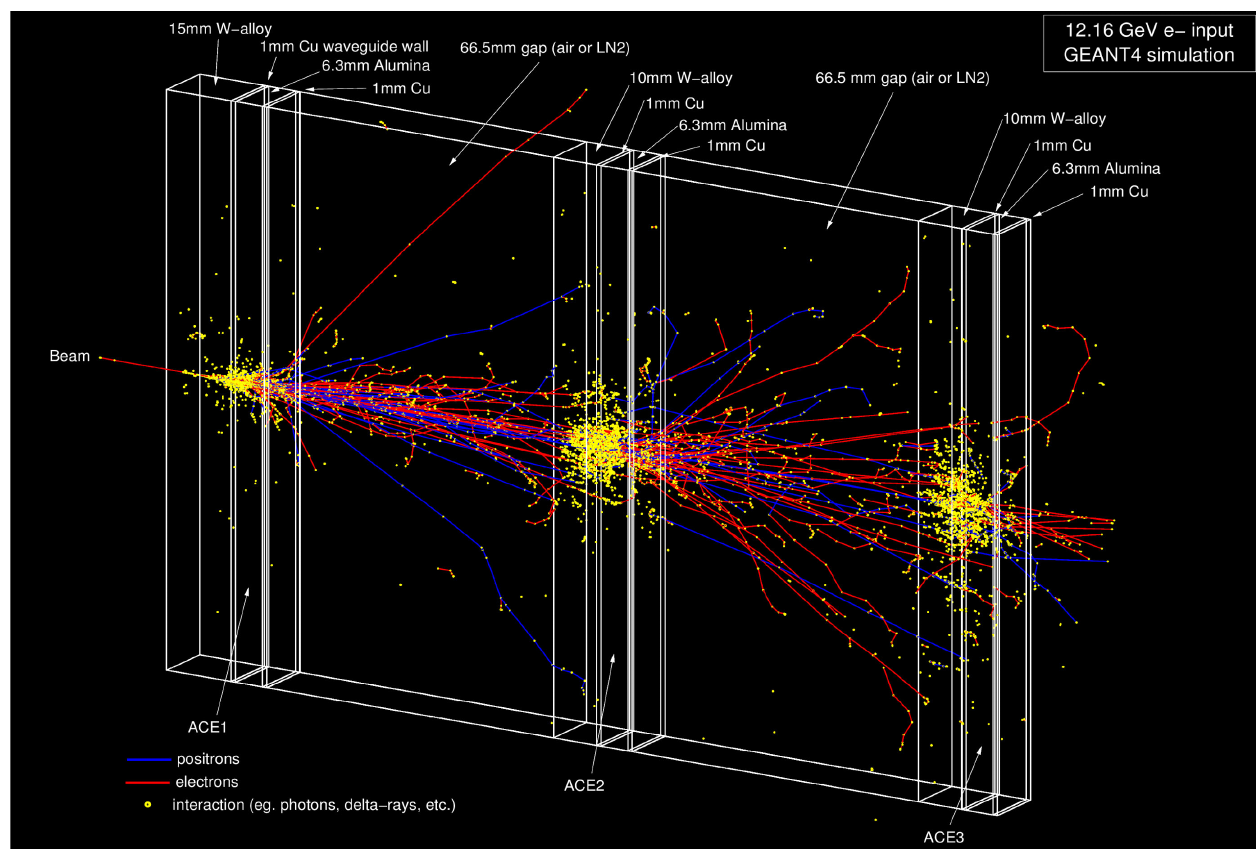
FIG. 2. Layout diagram, and GEANT 4 simulation of a single 12.16 GeVelectron event in our ACE detector system; in this case liquid nitrogen occupies the interelement